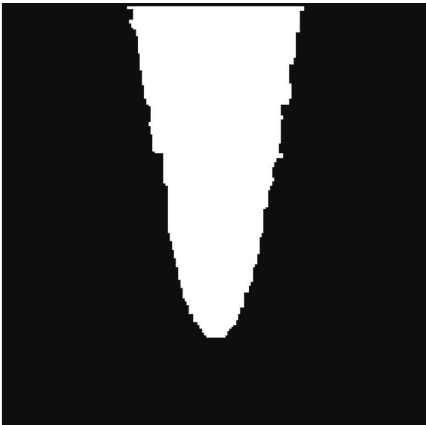
Figure 7: Plume detection mask for the synthetic refinery scene.